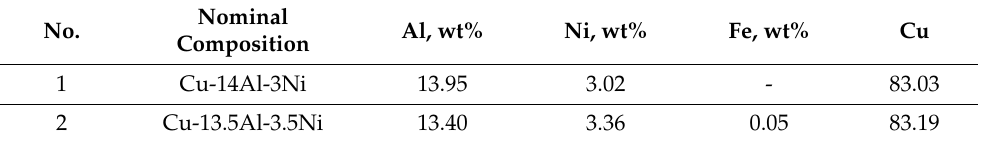
Table 1. Chemical spectroscopic analysis of the alloys Cu–14Al–3Ni and Cu–13.5Al–3.5Ni. No.